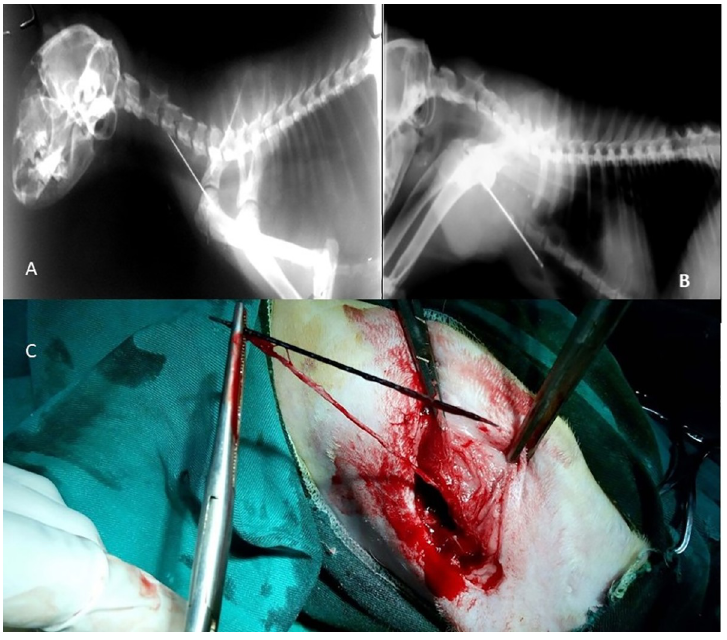
Fig 4. Foreign body lodgement at the thoracic inlet. a. Lateral radiographic view showing penetrating needle at the level of the thoracic inlet. b. Lateral radiographic view showing radiopaque needle with soft tissue abscessation from the axilla to the mammary glands. c. Removal of a needle with its suture material from the pectoral muscles.